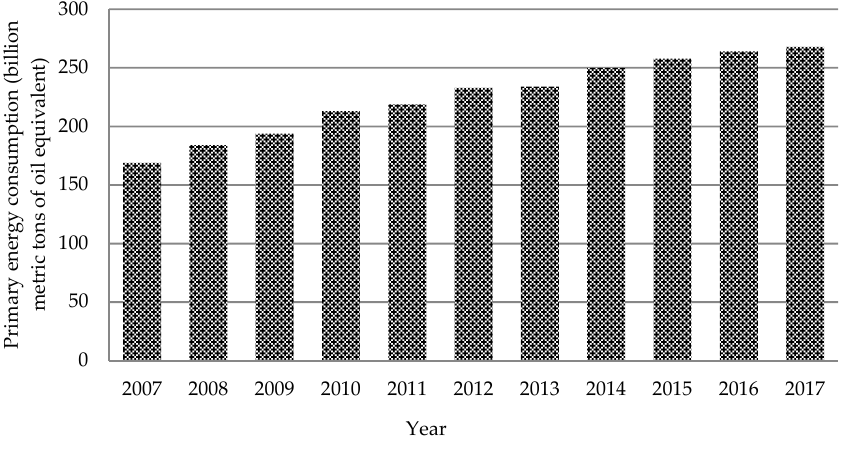
Figure 3. Growth of primary energy demand in KSA [8].